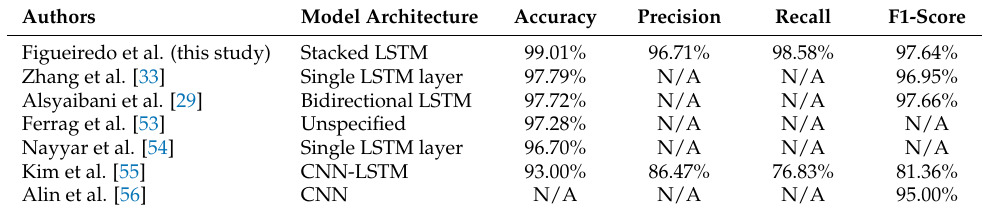
Table 5. Comparison with similar studies.